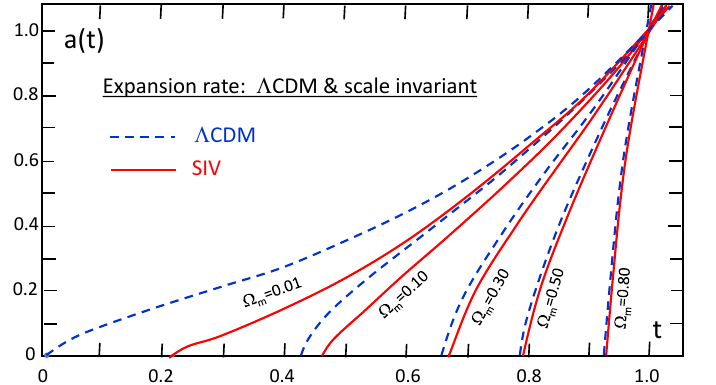
Figure 1. Expansion rates a ( t ) as a function of time t in the flat ( k = 0) Λ CDM and SIV models in the matter dominated era. The curves are labeled by the values of Ω m .